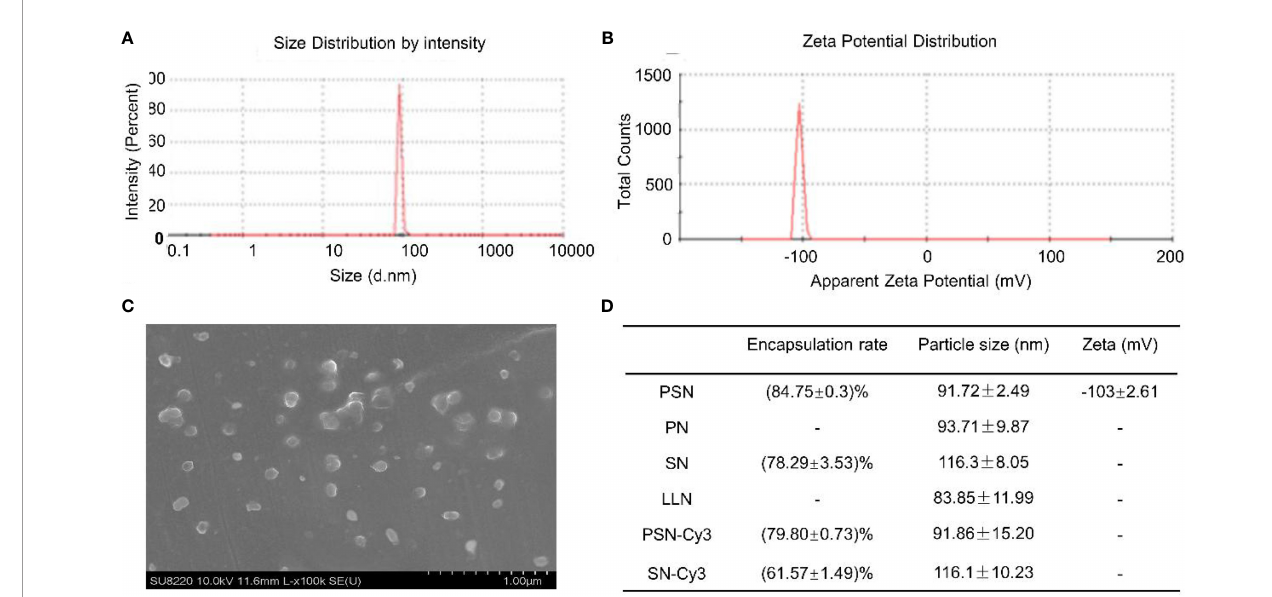
FIGURE 4 | Properties of liposomal nanoparticles. (A) Particle size of PSN. (B) Zeta potential of PSN. (C) The ultrastructural morphology of PSN detected by scanning electron microscope. (D) Data on encapsulation rates, particle sizes, and zeta potentials of liposomal